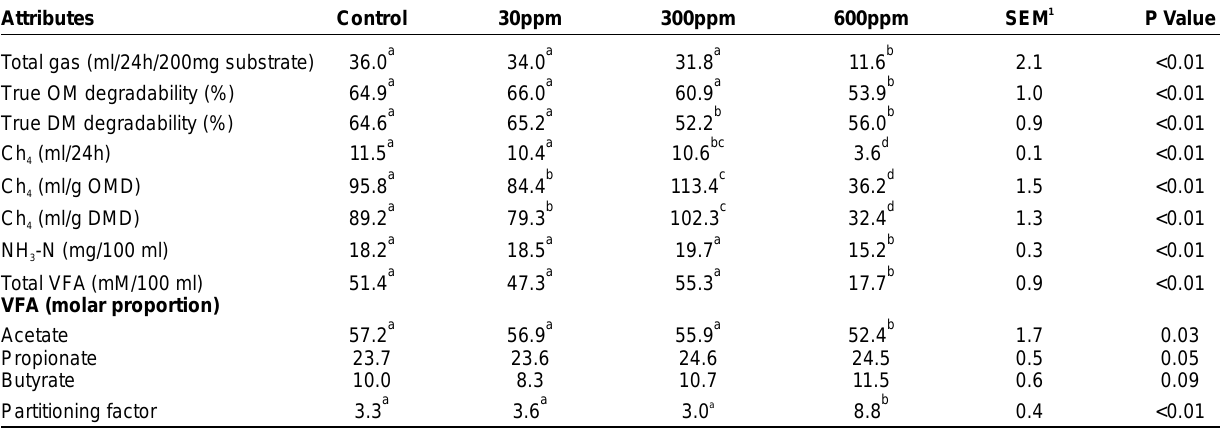
Table-4: Effect of different levels of oregano oil on in vitro fermentation in wheat straw based (Concentrate: Roughage= 50:50) diet